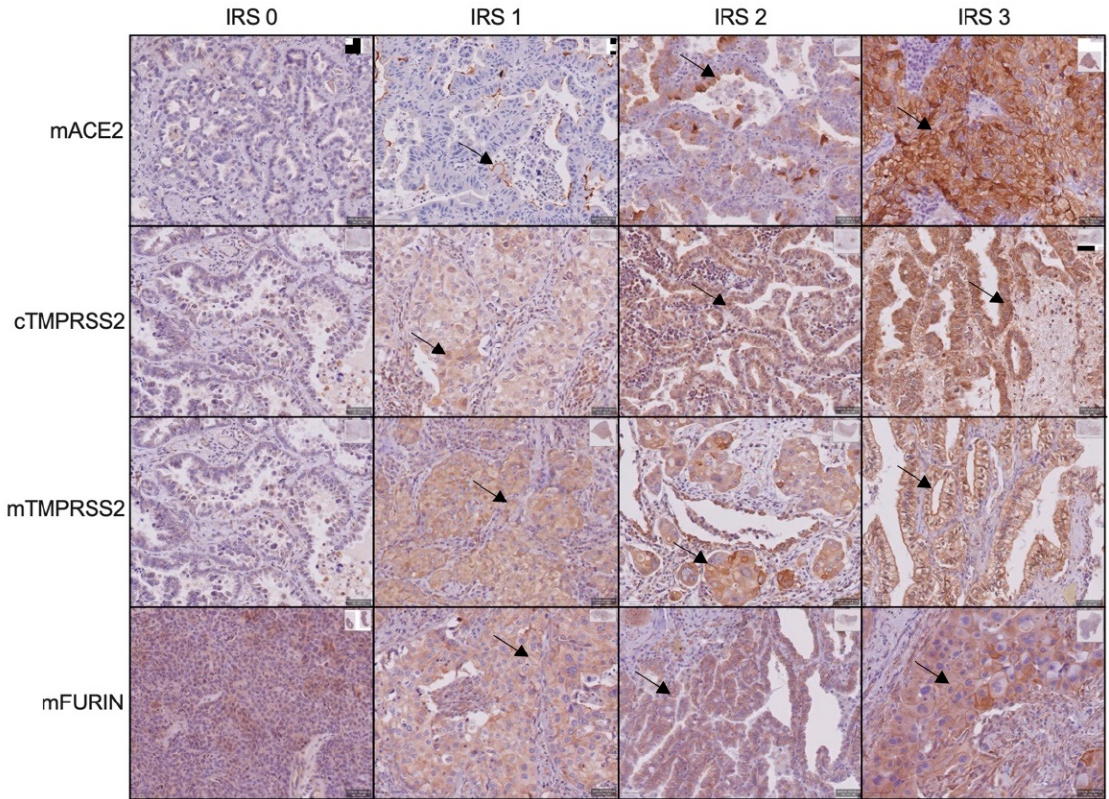
Figure 1. ACE2, TMPRSS2, and FURIN protein expression in NSCLC patients. Representative im- ages of patient samples with an immune reactivity score (IRS) ranging from 0 to 3. m: membranous; c: cytoplasmic.